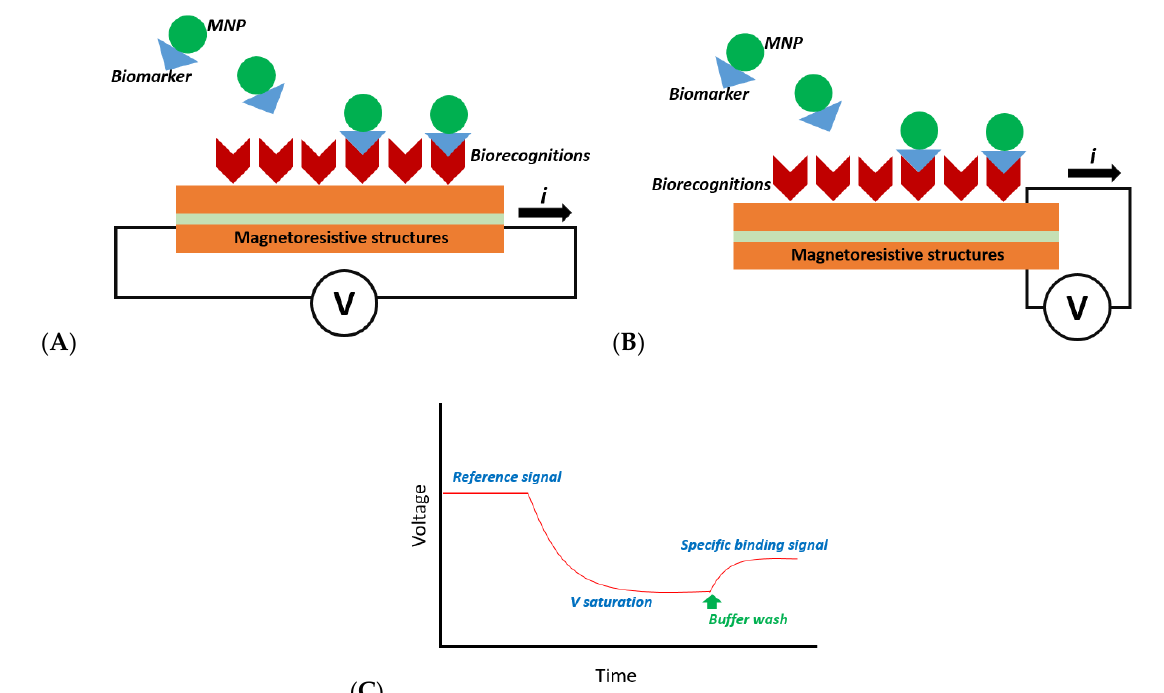
Figure 1. The general concept of an MR-based biosensor for the detection of MNP-labeled biomarkers with ( A ) the current in plane (CIP) of the electrical measurement and ( B ) the current perpendicular to plane (CPP). ( C ) The typical real-time response curve of the biomarker binding on the MR-based biosensor.